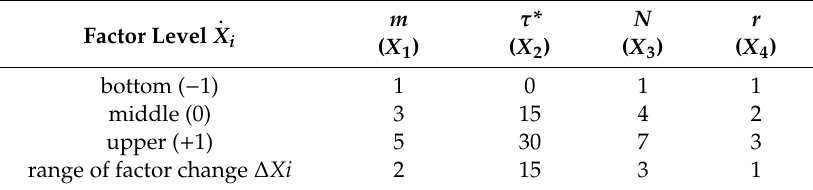
Table 4. Natural and standardized values of selected